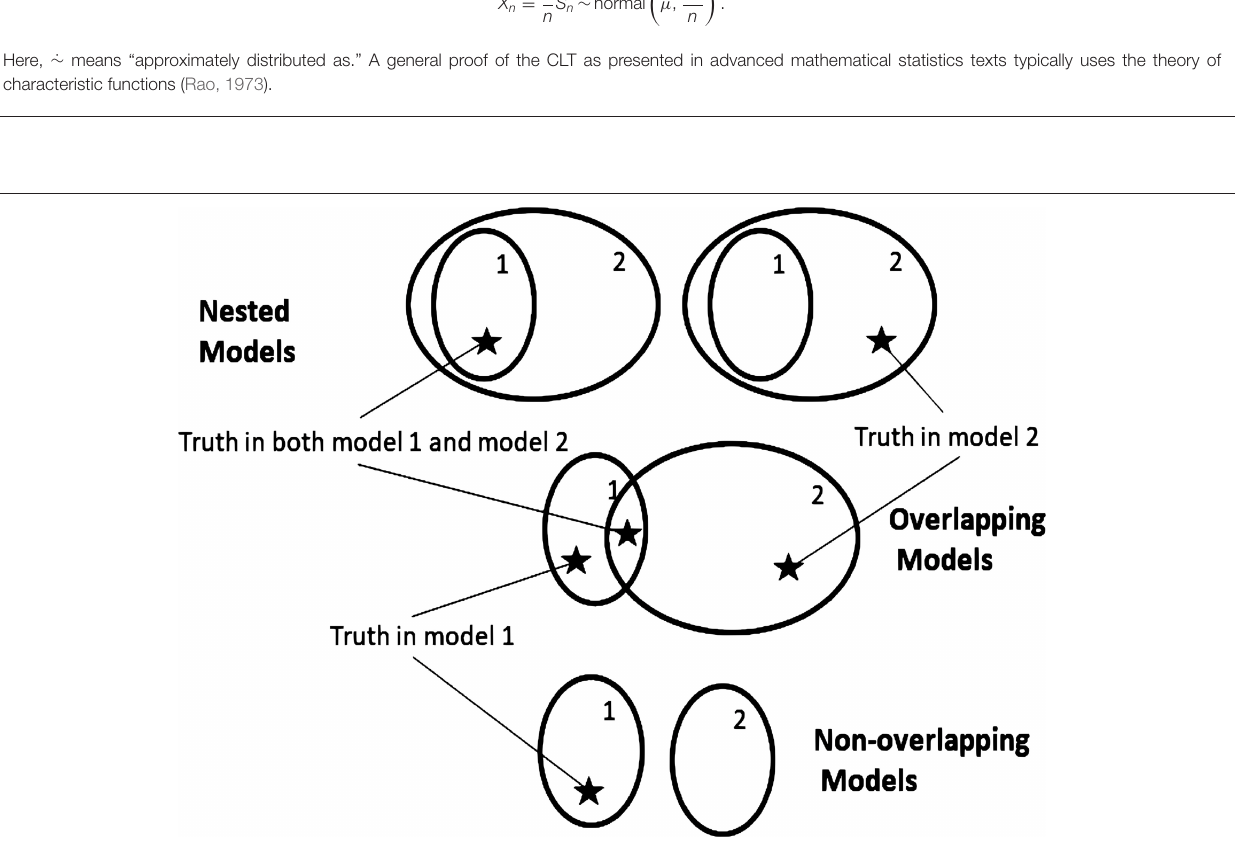
FIGURE 1 | Model topologies when models are correctly specified. Regions represent parameter spaces. Star represents the true parameter value corresponding to the model that generated the data. Top : a nested configuration would occur, for example, in the case of two regression models if the first model had predictor variables R 1 and R 2 while the second had predictor variables R 1 , R 2 , and R 3 . Middle : an overlapping configuration would occur if the first model had predictor variables R 1 and R 2 while the second had predictor variables R 2 and R 3 . Three locations of truth are possible: truth in model 1, truth in model 2, and truth in both models 1 and 2. Bottom : an example of a non-overlapping configuration is when the first model has predictor variables R 1 and R 2 while the second model has predictor variables R 3 and R 4